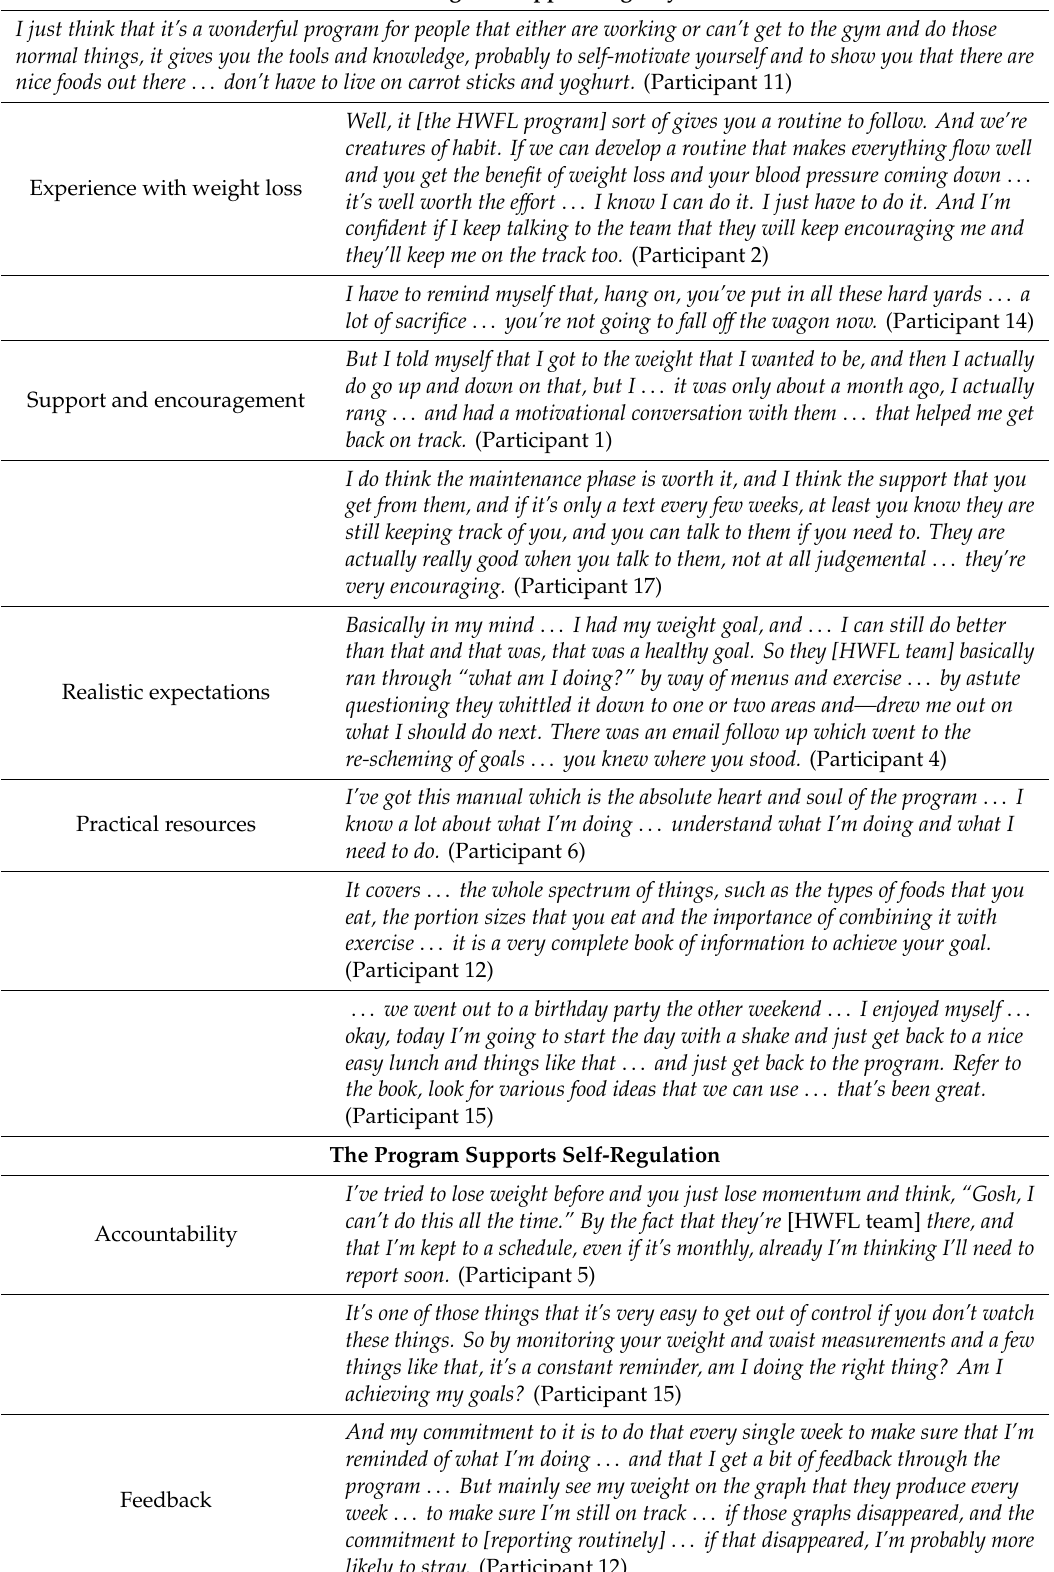
Table 3. Quotes underpinning the themes of agency and self-regulation. The Program Supports